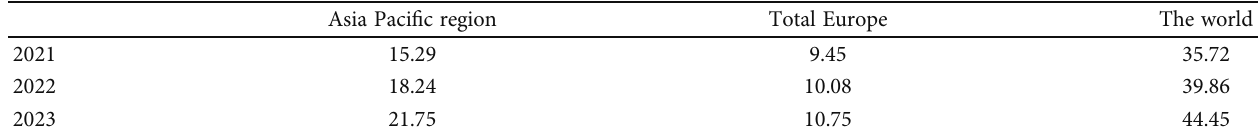
Table 18: Predictions for the renewable energy consumption over the next 3 years.